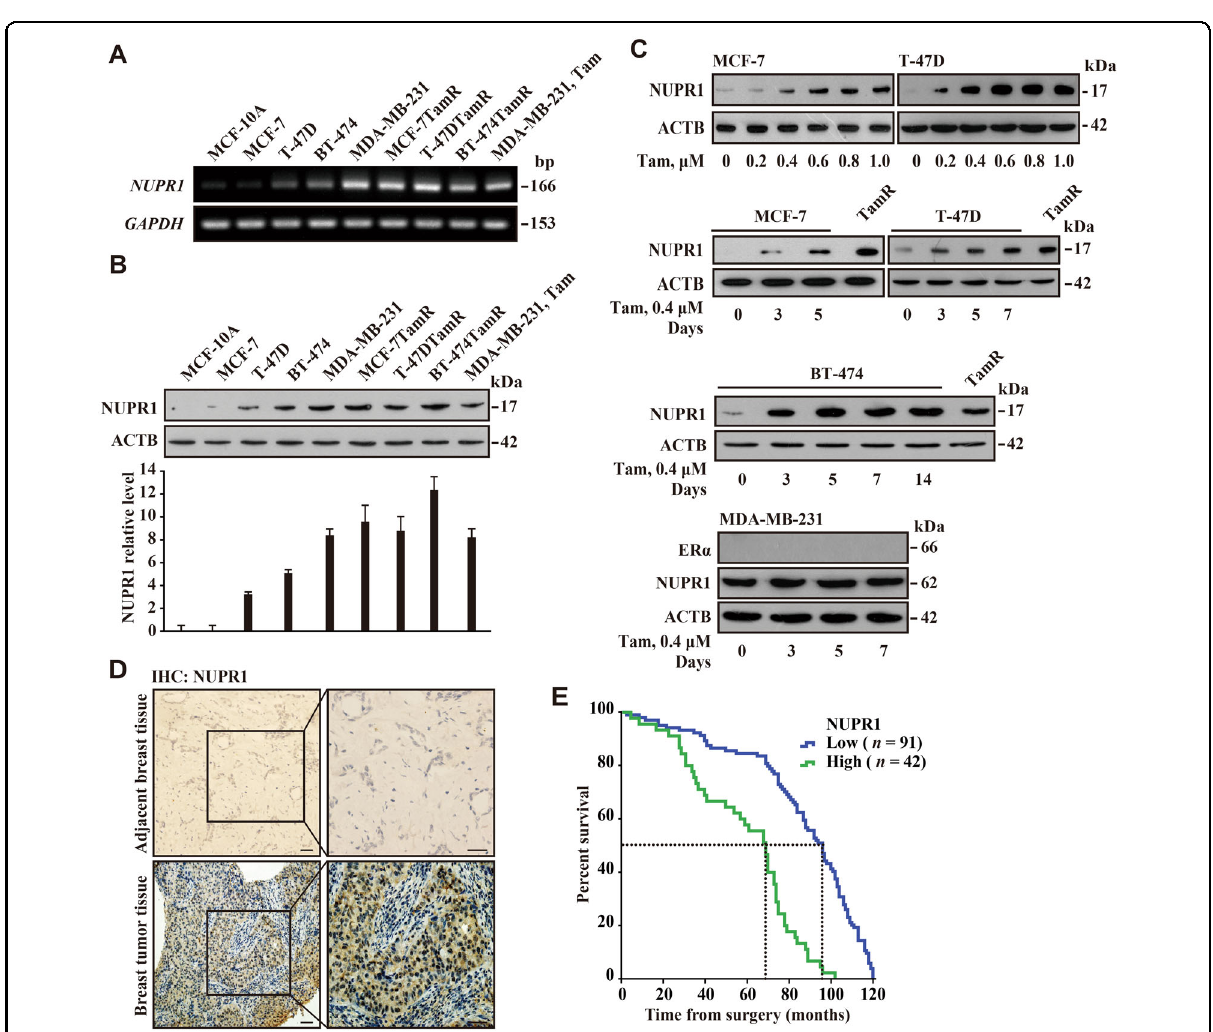
Fig. 1 NUPR1 is induced by Tam and correlates with lower overall survival. A To determine NUPR1 expression levels in breast cancer cell lines as indicated, RT-PCR products were evaluated by agarose gel electrophoresis. RNA levels were normalized to GAPDH expression. bp base pairs. B Immunoblots were carried out with anti-NUPR1 and anti-ACTB antibodies in the cell lines used in A . Experiments in both A and B were performed in triplicate, yielding similar results. Lower panel, NUPR1 relative protein level. C Endogenous NUPR1 was induced by 0.4 µM Tam in ESR1-positive breast cancer cell lines as indicated. Western blot analysis of these cells treated for the indicated time was carried out as described in B . D Representative distribution of NUPR1 by IHC in clinical breast cancer specimens and their adjacent noncancerous tissues from the patient of origin (IHC, brown). Scale bars, 50 μ m. E Kaplan – Meier plots of overall survival after surgery for 133 breast cancer subjects with low (0 – 5.0 staining scores, blue lines; n = 91) or high (5.1 – 10.0 staining scores, green lines; n = 42) NUPR1 expression ( P = 0.0021). The hazard ratio for high NUPR1 expression was 6.998 (CI 4.128 – 11.862, log-rank test). Median survival was more than 95.4 months for the low NUPR1 expression group versus 68.1 months for the high NUPR1 expression